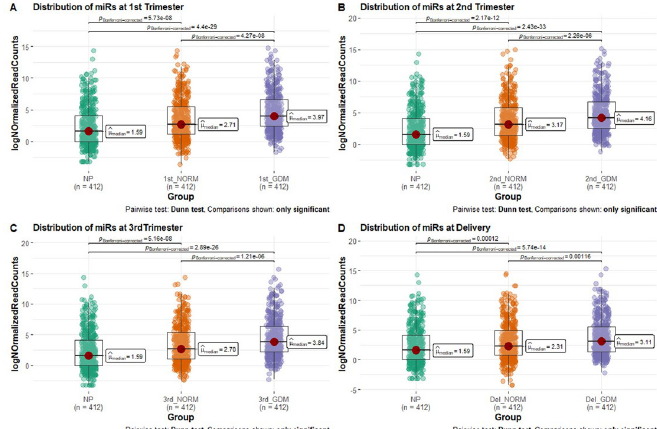
Fig 3. Distribution of EV derived miRNAs at three trimesters of gestation and at delivery in normal and gestational diabetes mellitus (GDM). Boxplots show the distribution of EV-derived miRNAs in non-pregnant (NP), normal pregnant (NORM) and gestational diabetes (GDM) maternal plasma samples in (A) first trimester, (B) second trimester, (C) third trimester and (D) at delivery. Abundance is shown as Log-normalized read counts. Significance of the difference between groups was calculated using Kruskal–Wallis one-way analysis of variance followed by post-hoc analysis using Dunn’s test. Bonferroni corrected p-values demonstrate significant differences.